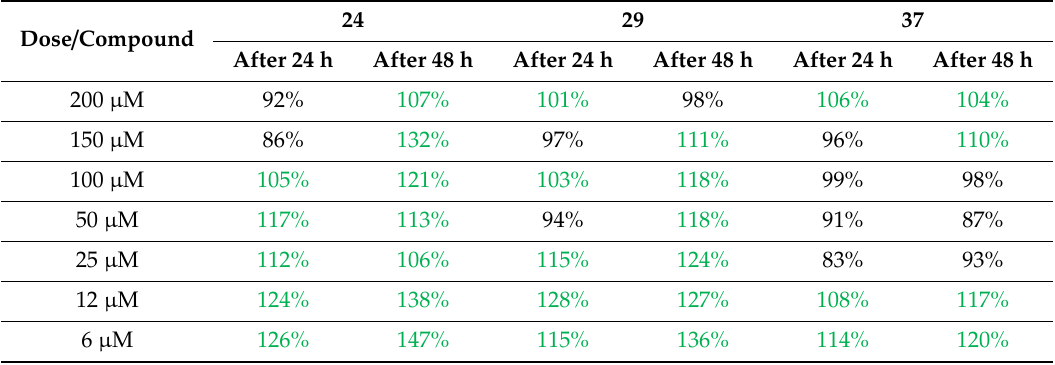
Table 5. The cell proliferation in % according to control after 24 h and after 48 h exposition on studied compounds in HeLa cell